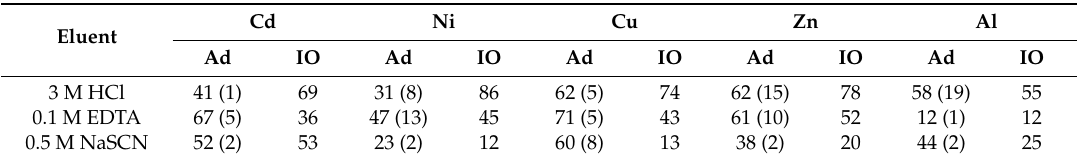
Table 2. Elution efficiency (%) and (SD) for metals loaded in Adsorbsia As600 (Ad) and Iontosorb oxin (IO).